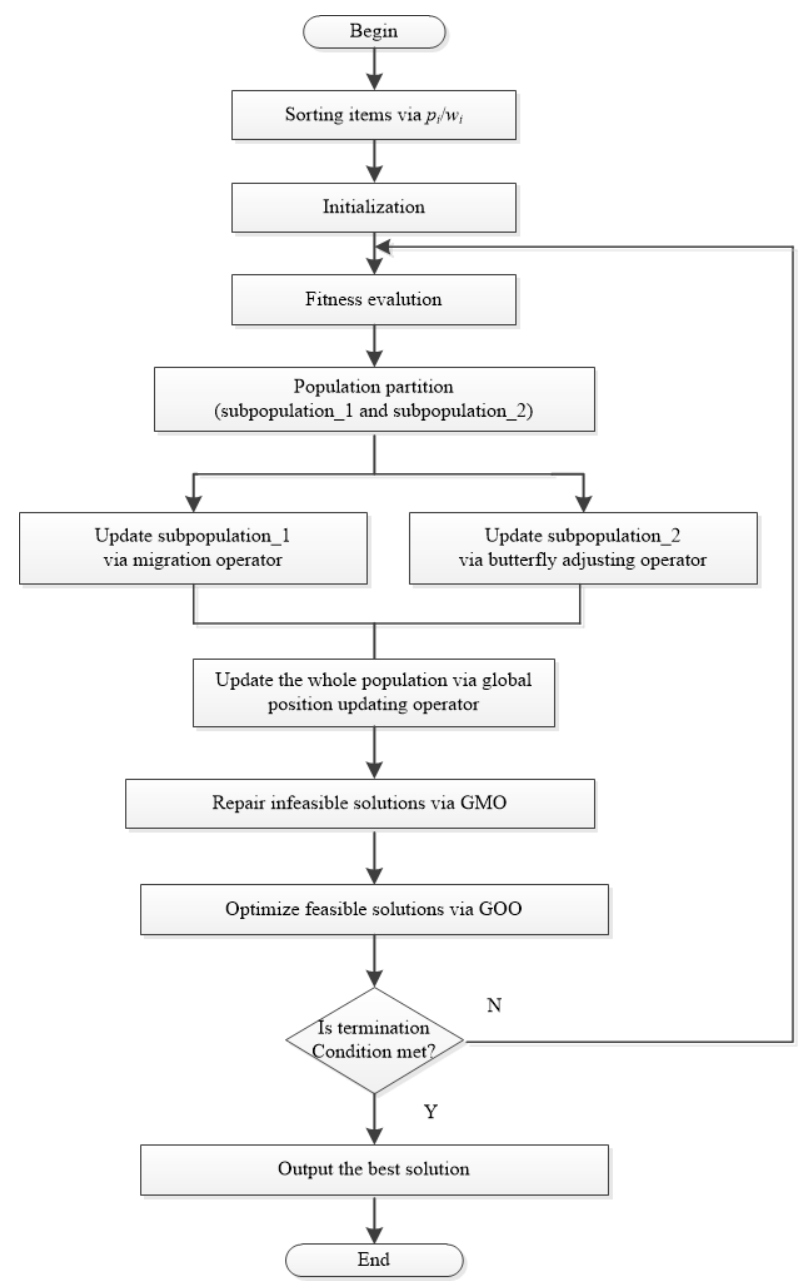
Figure 2. Flowchart of global position updating operator (GMBO) algorithm for 0-1 knapsack (KP) problem.